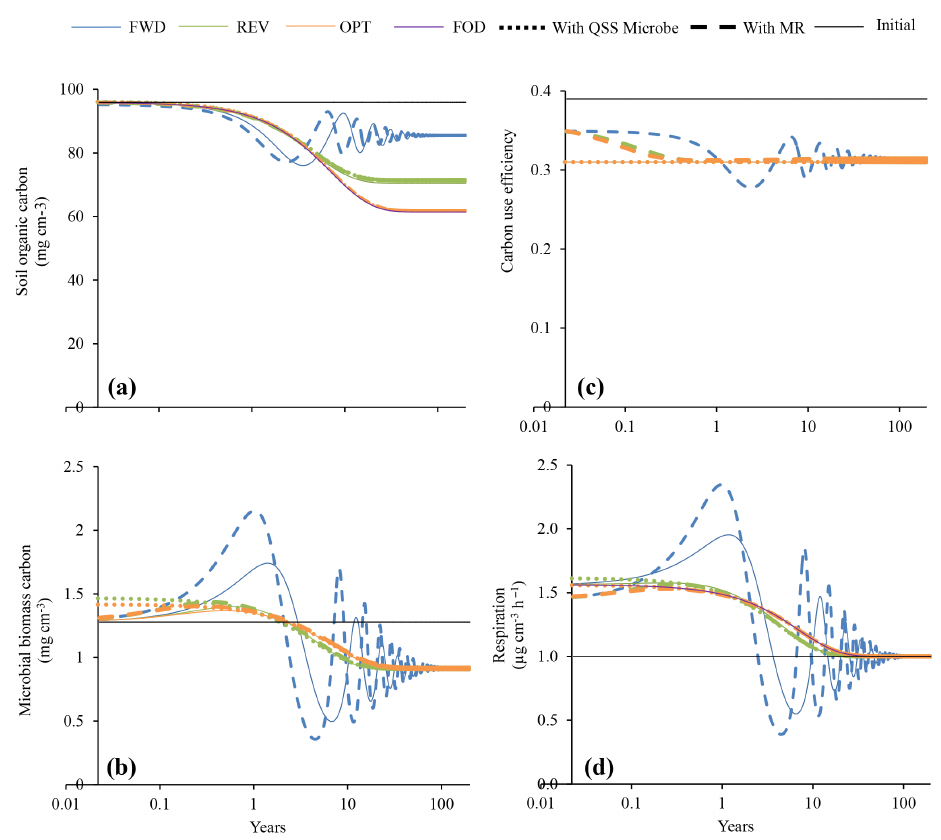
Figure 3. Responses of (a) soil organic carbon, (b) microbial biomass carbon, (c) CUE, and (d) respiration to a 5 ◦ C warming for all models if microbial biomass is assumed to be at quasi-steady state (QSS, dotted lines) and if separation of maintenance and growth respiration are considered (dashed lines). Coloured thin lines represent base models. The black thin line represents initial values, equilibrated at 15 ◦ C. Dashed lines (growth and maintenance) and dotted lines (quasi-steady state) represent modifications for REV and OPT models, respectively. In the OPT model, simulations are carried out at zero enzyme production cost (i.e. µ 2 = k p · c =